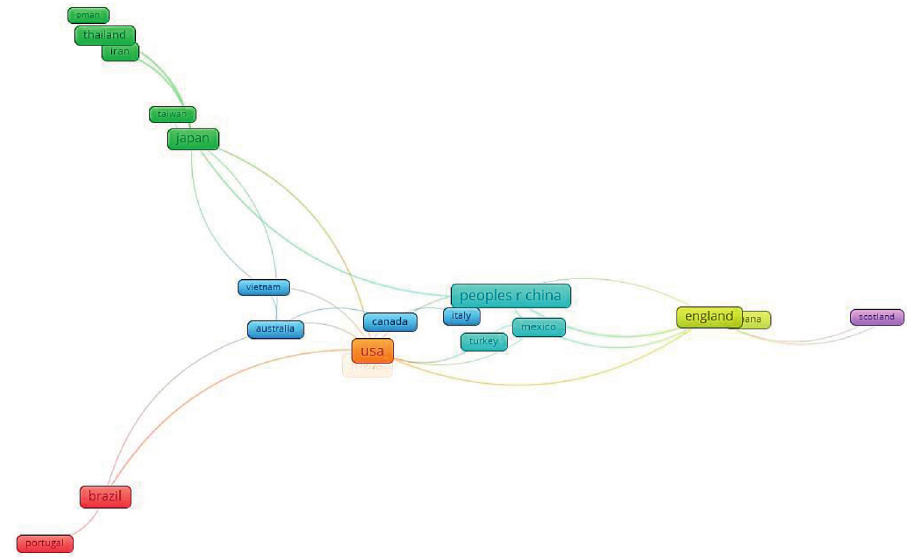
Figure 6: Countrywise